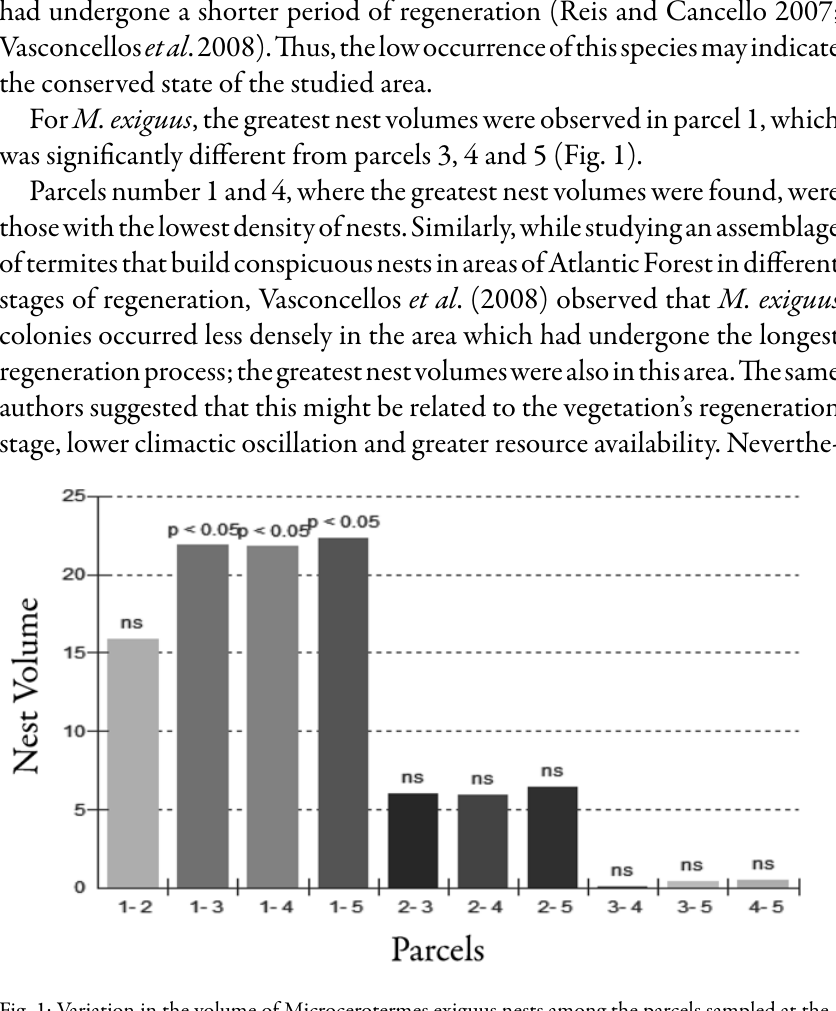
Fig. 1: Variation in the volume of Microcerotermes exiguus nests among the parcels sampled at the Tapacurá Ecological Station, based on the Kruskal-wallis test